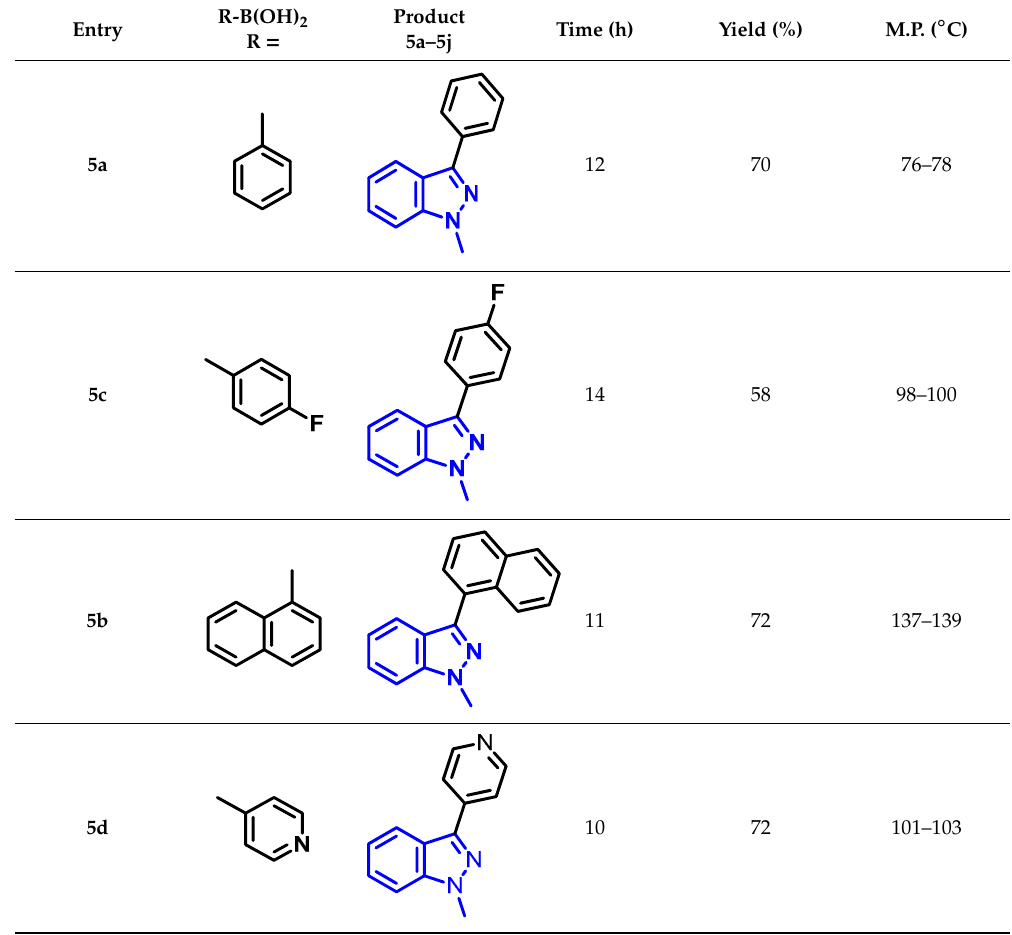
Table 2. Details of the series of compounds 5a–5j.